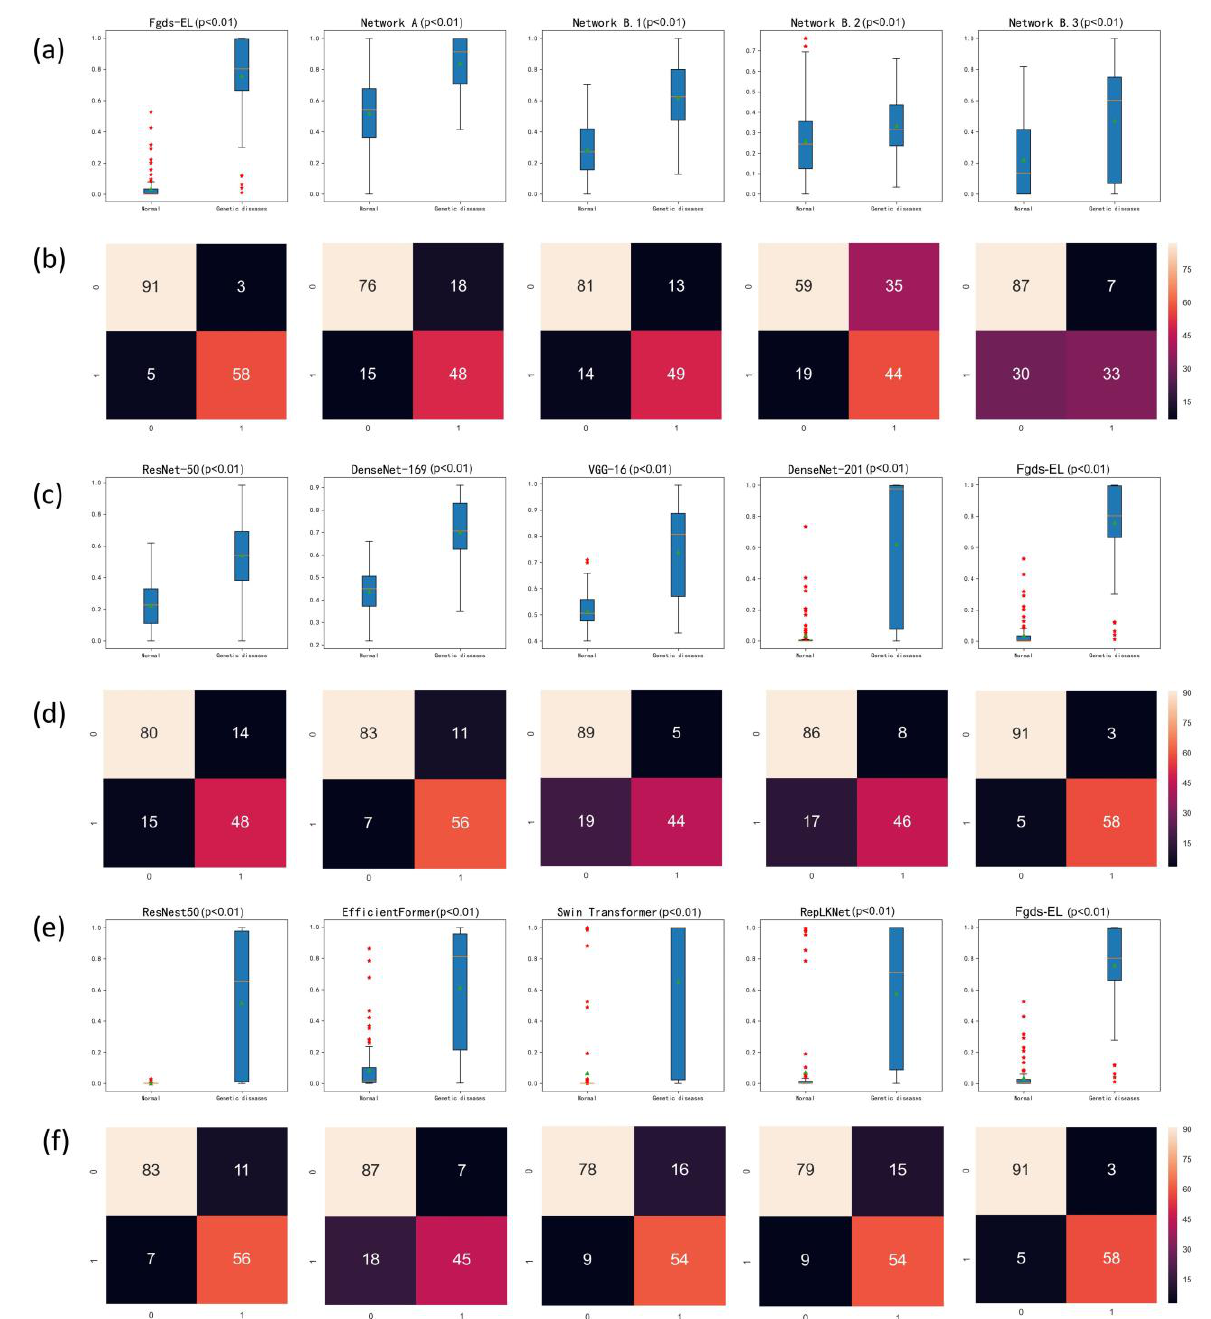
Figure 4. Risk scores (range 0 – 1) and confusion matrix predicted by the deep learning model for discerning fetal genetic diseases. Scores closer to 1 denote a higher probability of genetic diseases. The upper and lower bounds of the box refer to the 25th and 75th percentiles, and the line intersection in the box refers to the median. Green triangles and red stars represent outliers and mean values respectively. Whiskers refer to the full range of risk scores. In the confusion matrix, the horizontal coordinate is the predicted label, and the vertical coordinate is the true label. ( a ) The risk scores predicted by the different sub-networks and Fgds-EL in the test set. ( b ) The confusion matrix of the different sub-networks and Fgds-EL in the test set. ( c , e ) The risk scores predicted by the different deep learning models in the test set. ( d , f ) The confusion matrix of the different sub-networks and Fgds-EL in the test set.